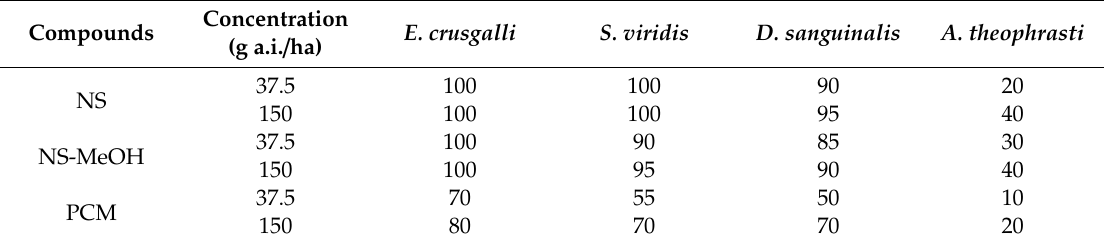
Table 4. The growth inhibition rates of E. crusgalli , S. viridis , D. sanguinalis , and A. theophrasti for NS, NS-MeOH, and PCM. (Inhibition rate /